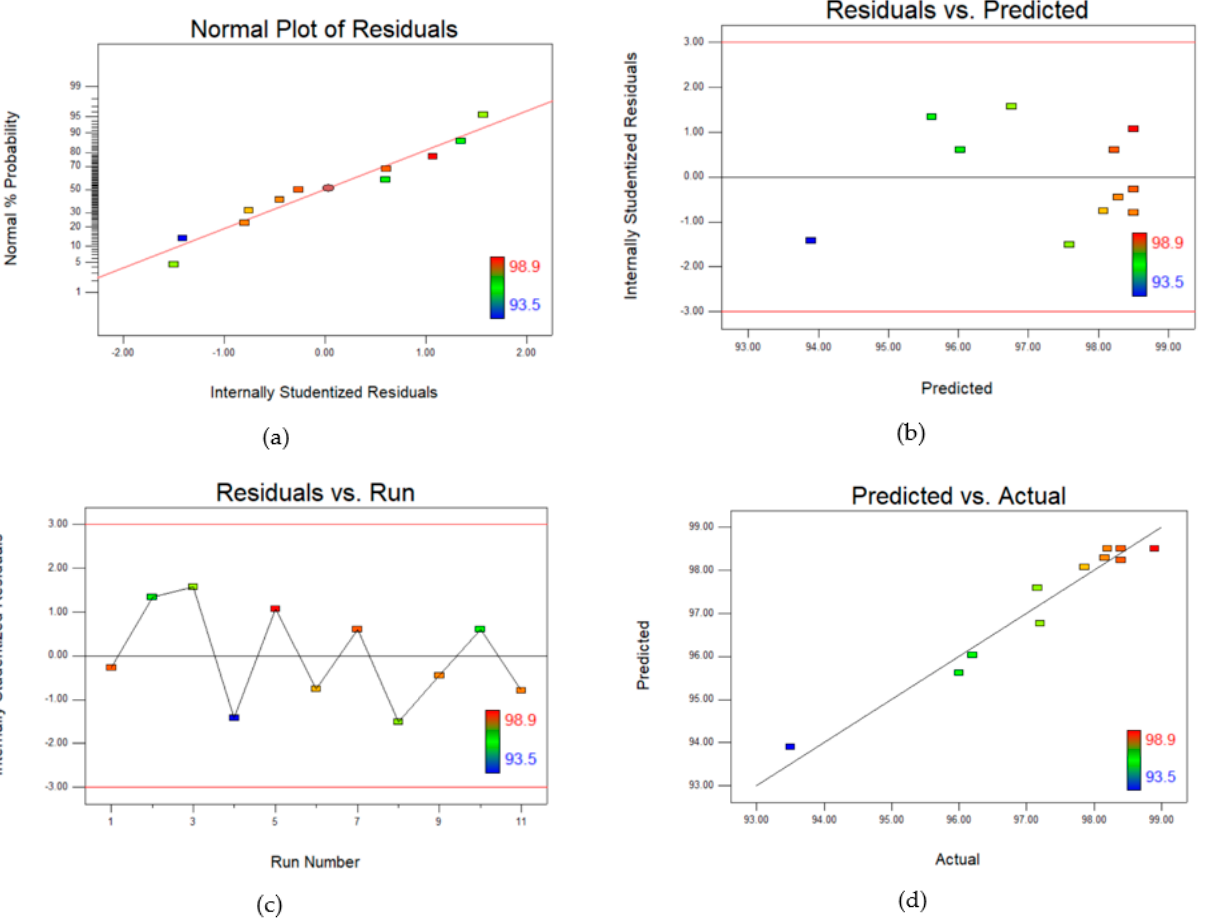
Figure 3. ( a – c ) Residual plots and ( d ) Predicted vs Actual plot for Central composite design (CCD) for salt rejection